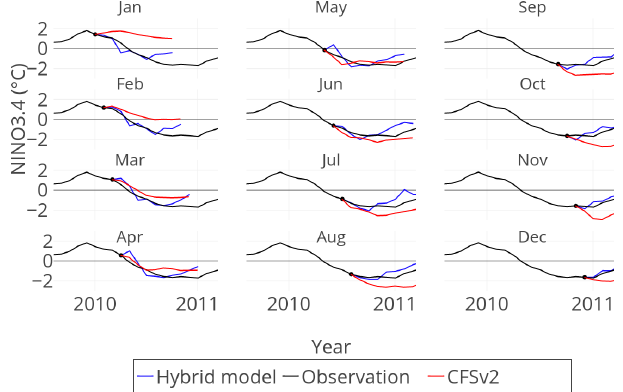
Figure 6. The 9-month ahead prediction starting from every month in the year 2010. Blue is the hybrid model prediction with ARIMA(12,1,1), 2 × 1 × 1 ANN structure and attributes are the 3- month running mean of WWV, PC 2 and SC. The black line is the observed index. Red is the mean of the CFSv2 ensemble